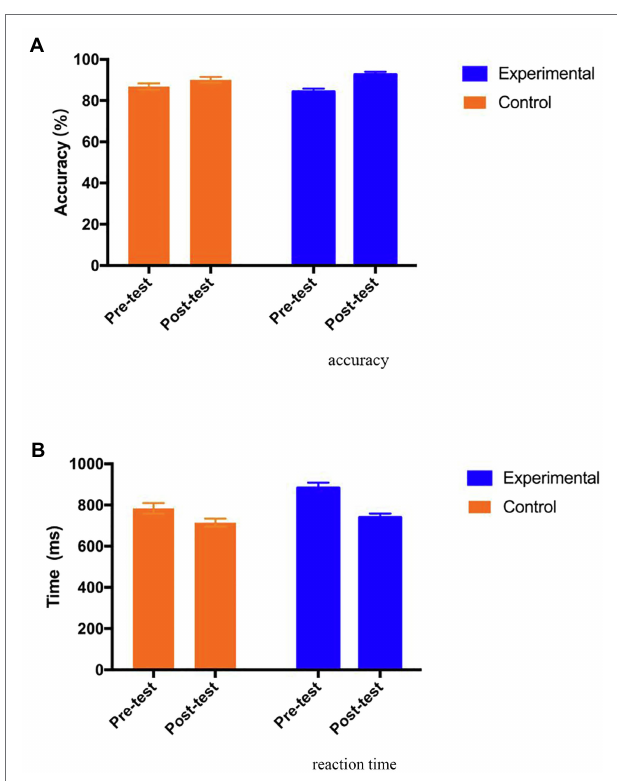
FIGURE 5 | Adjusted means (SEs) for working memory accuracy (A) and reaction time (B) by group and